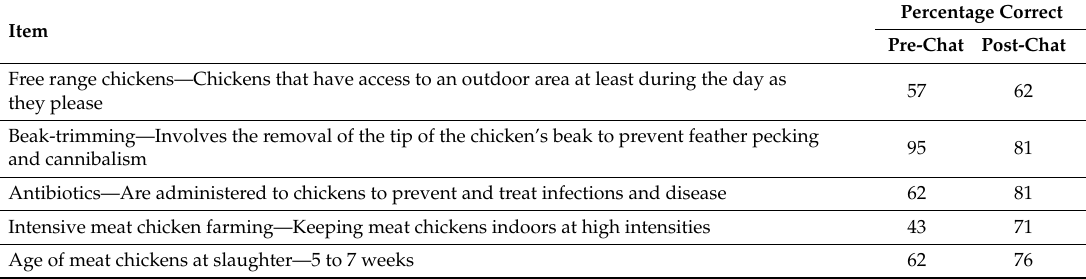
Table 4. Percentage of participants who correctly answered objective knowledge items on the pre- and post-chat